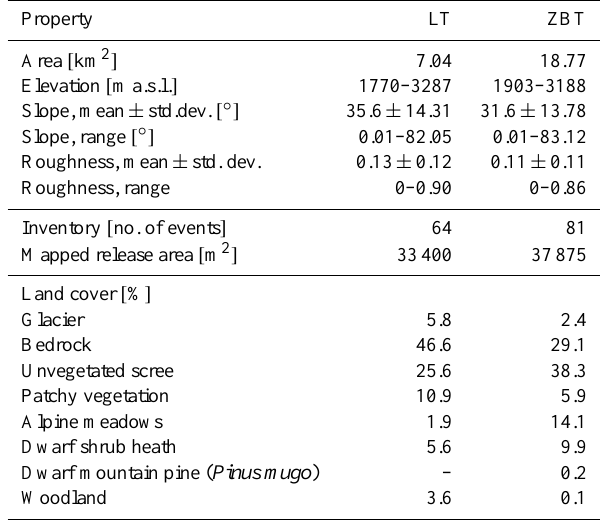
Table 1. Selected properties of the study